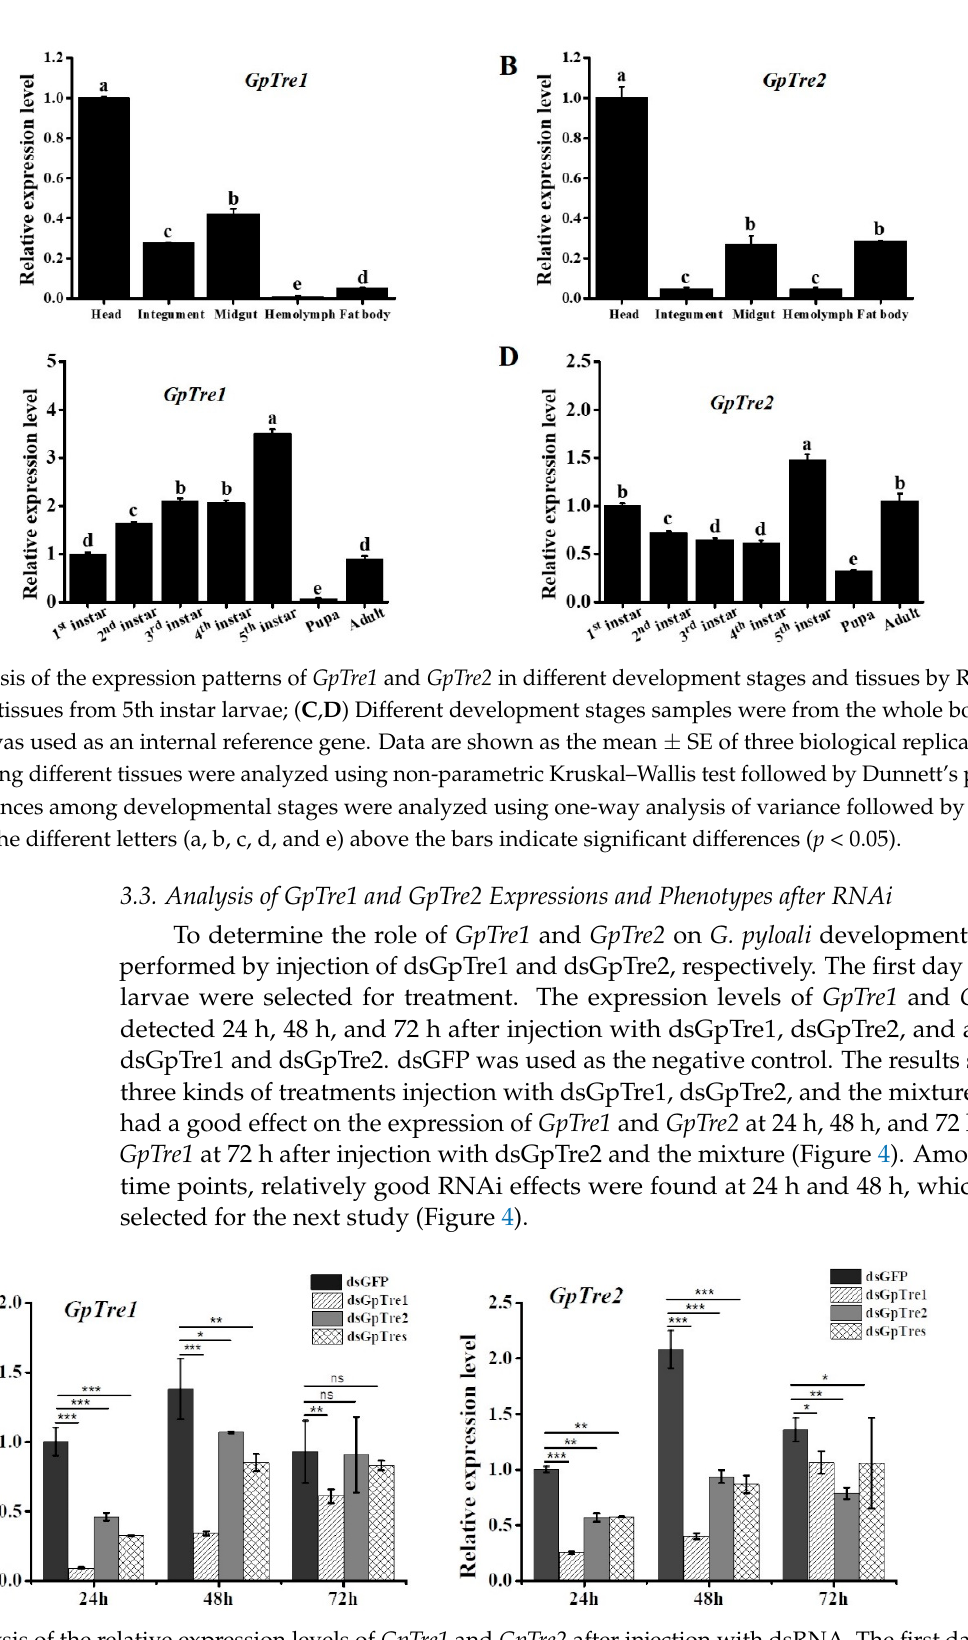
Figure 4. Analysis of the relative expression levels of GpTre1 and GpTre2 after injection with dsRNA. The first day of 5th instar larvae were selected for treatment. The GpRpl32 gene was used as an internal reference gene. Data are shown as the mean ± SE of three biological replicates. Differences between each dsRNA and dsGFP group within each time point were compared using t -test. Asterisks above the bars indicate significant differences (* p < 0.05; ** p < 0.01; *** p < 0.001; ns, no significance difference).